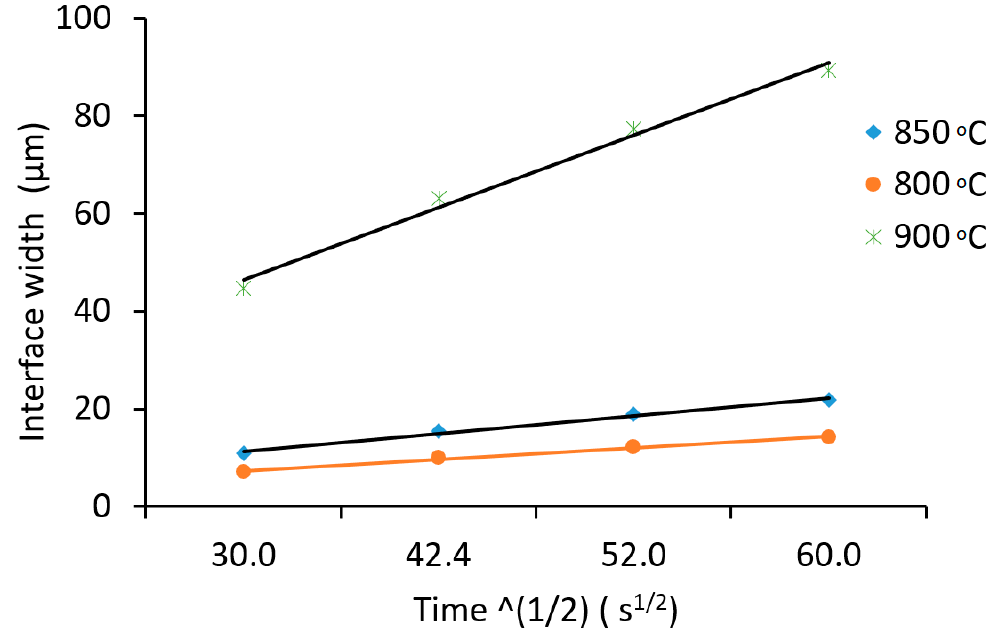
Figure 14. Variation of the width of the reaction layer as a function of the diffusion bonding conditions.